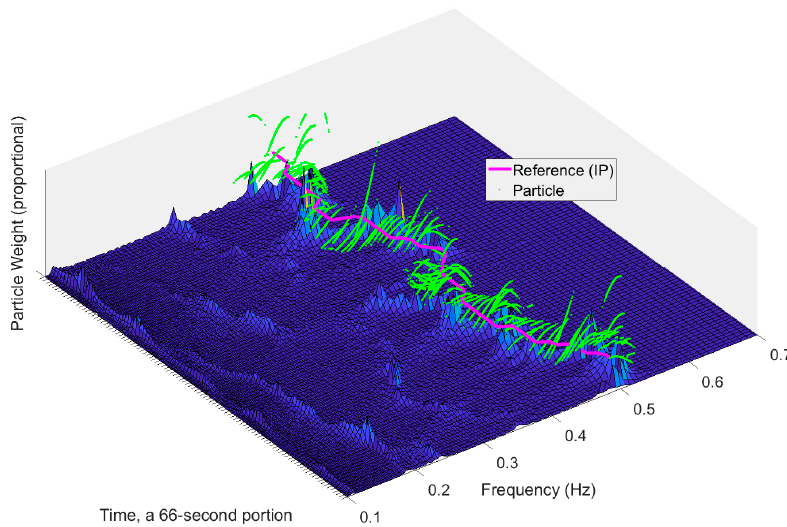
Figure 4. Response of the particle filter to a 66-s segment of subject data in wavelet synchrosqueezing transform (WSST). Particle filter exhibits fast response to underlying signal variations given that time resolution of the system model is